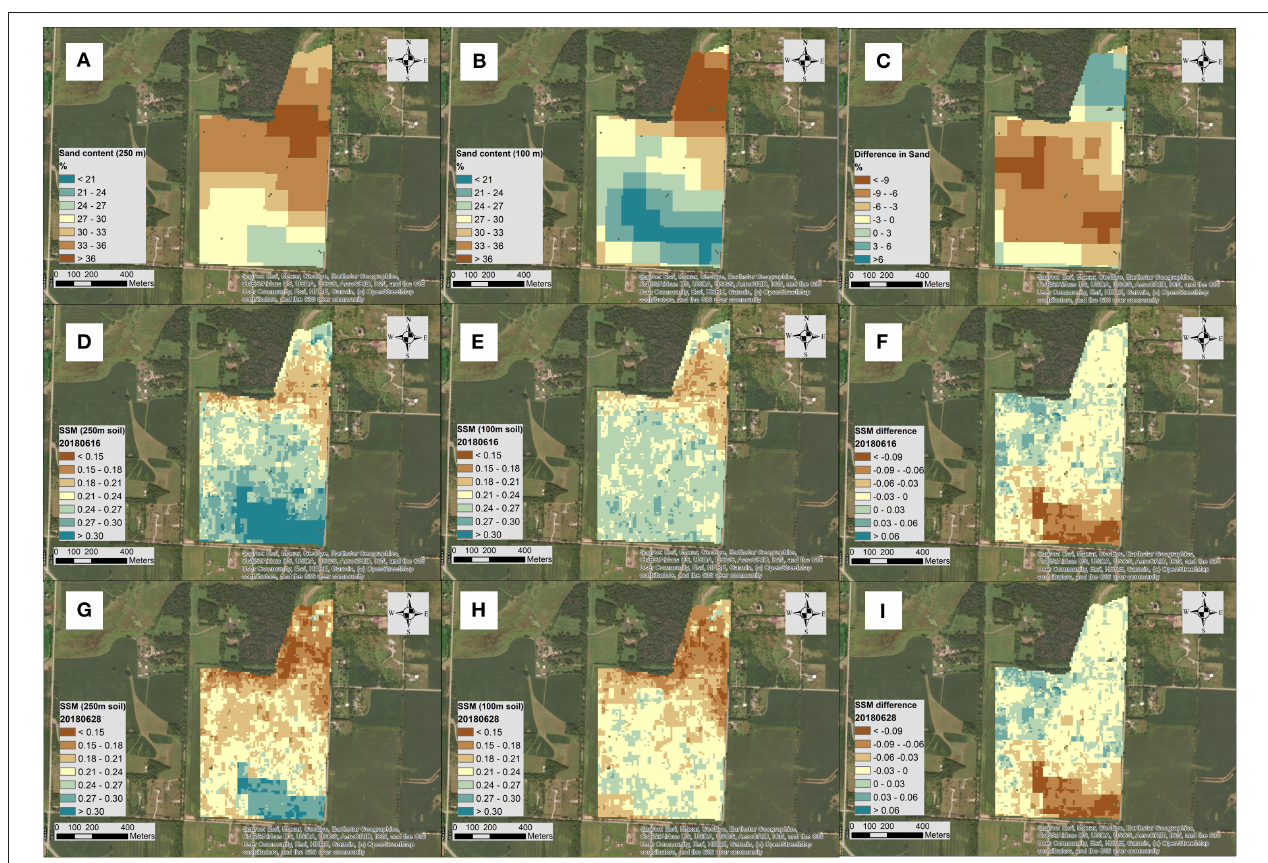
FIGURE 9 | Maps of soil sand content (%) at 250m (obtained from Hengl et al., 2017, resampled to 100 m with bilinear interpolation, A ) and 100m (obtained from Ramcharan et al., 2018, B ) with the predicted surface soil moisture (SSM, m 3 m − 3 ) from the quantile random forest (QRF) model (without local calibration— “spiking”) using the 250m (D,G) and 100m (E,H) soil property maps on wet (2018/06/16) and dry (2018/06/28) soil conditions across a cropland in Wisconsin, USA. The differences in soil sand content (C) and differences in estimated SSM between 100 and 250 m soil property maps (F,I) are also